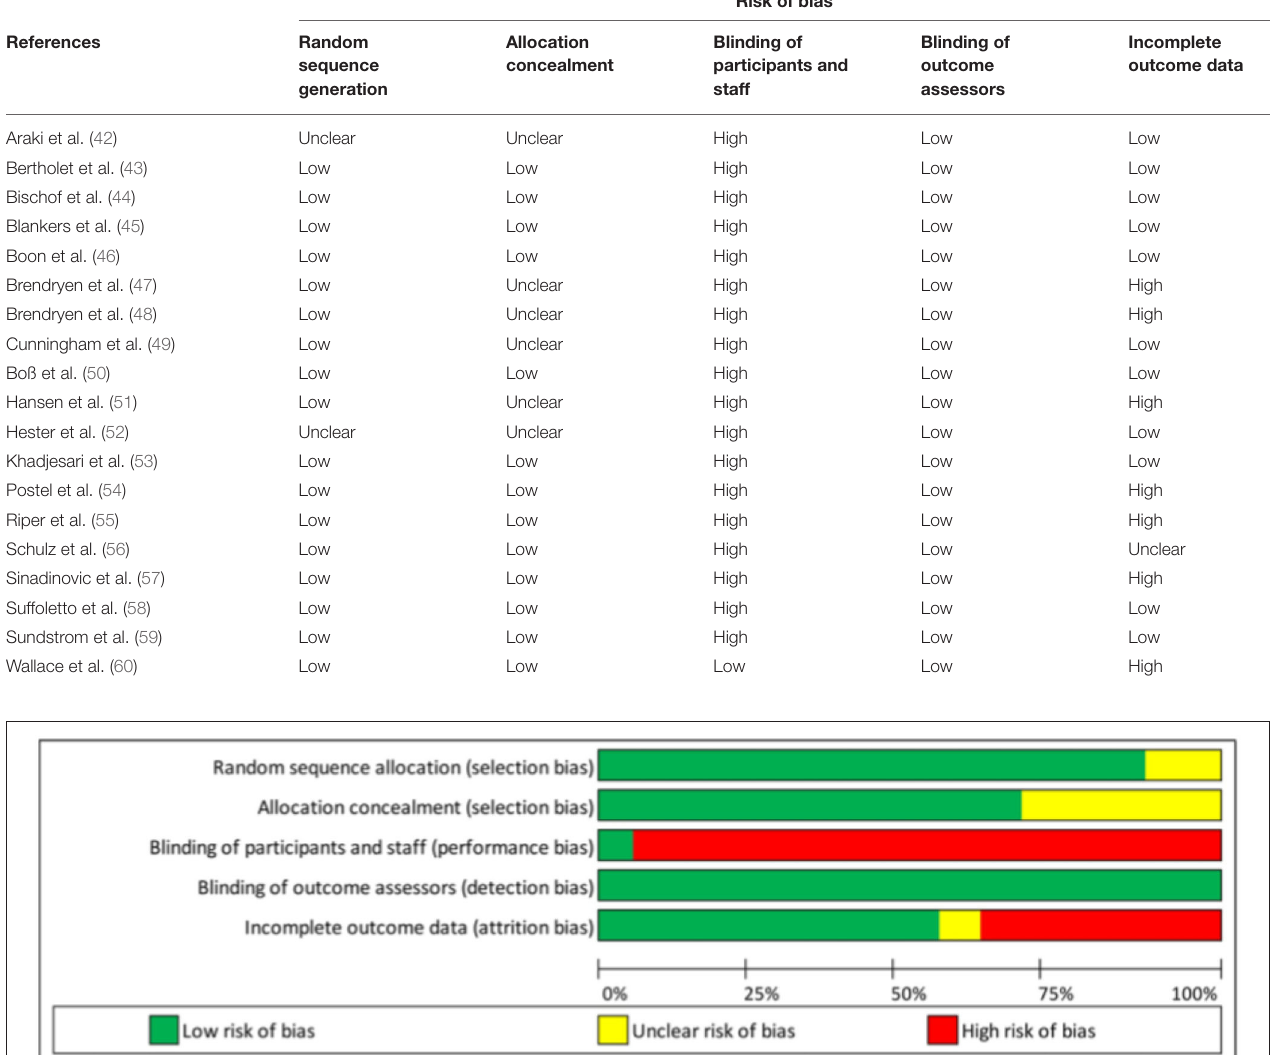
TABLE 1 | Example of a risk-of-bias assessment for 19 RCTs as reported by Riper et al. (41) ( Supplementary Table 1 ).